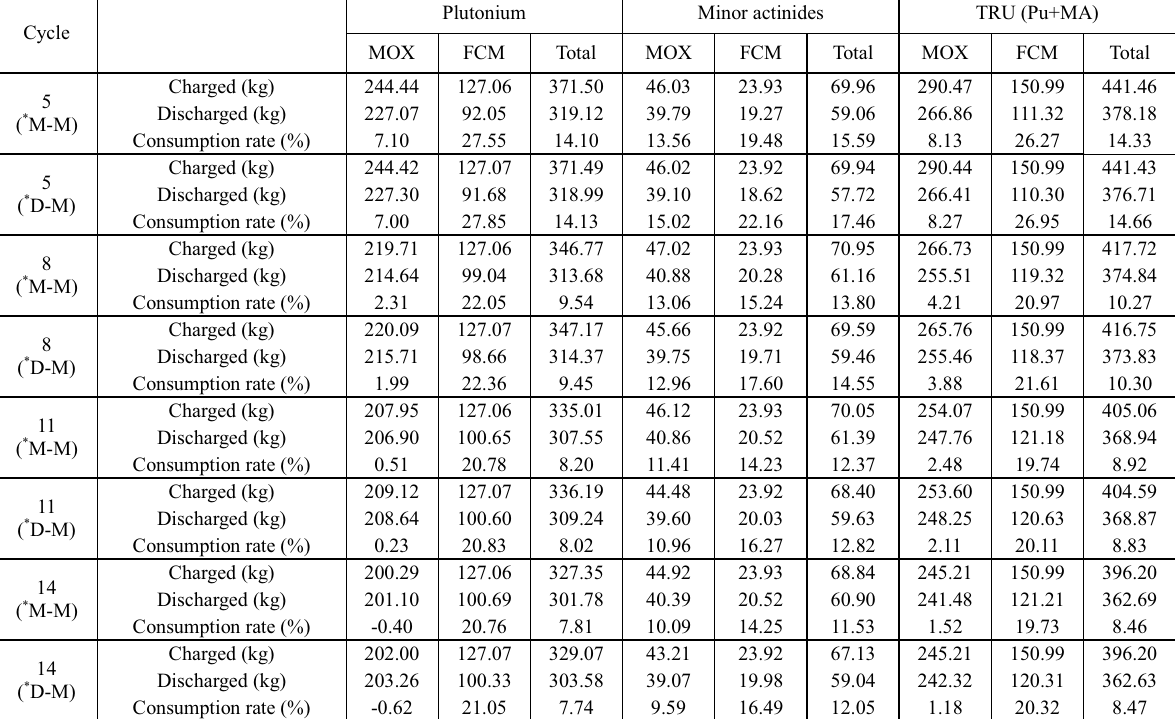
Table IV. Summary of TRU mass flow analysis for 5 th , 8 th , 11 th , and 14 th cycle calculated